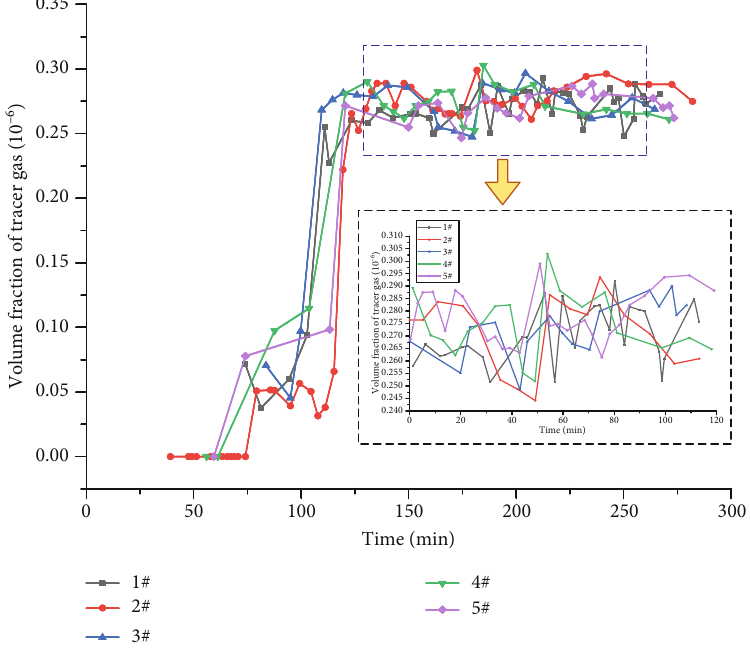
Figure 11: Tracer gas volume fraction in the 4302